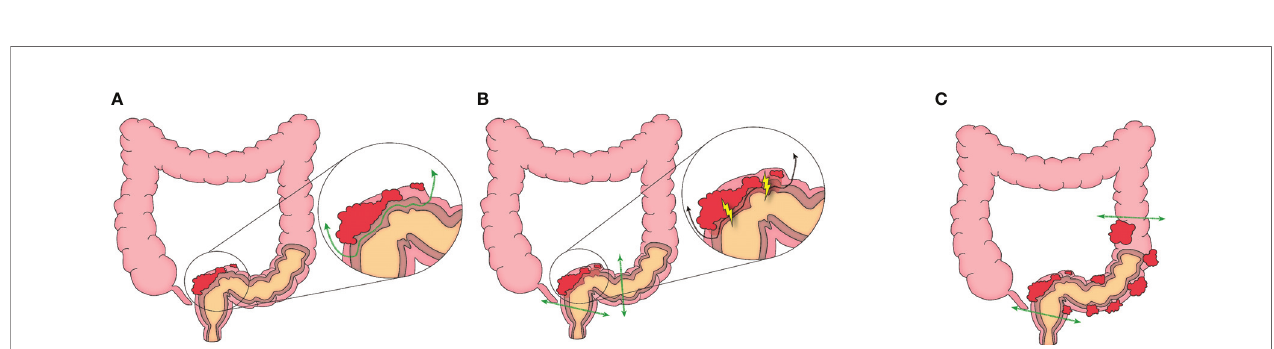
FIGURE 2 | Clinical phenotypes by tumor separability (A) Focal and separable type (B) Focal and inseparable type (C) Diffuse